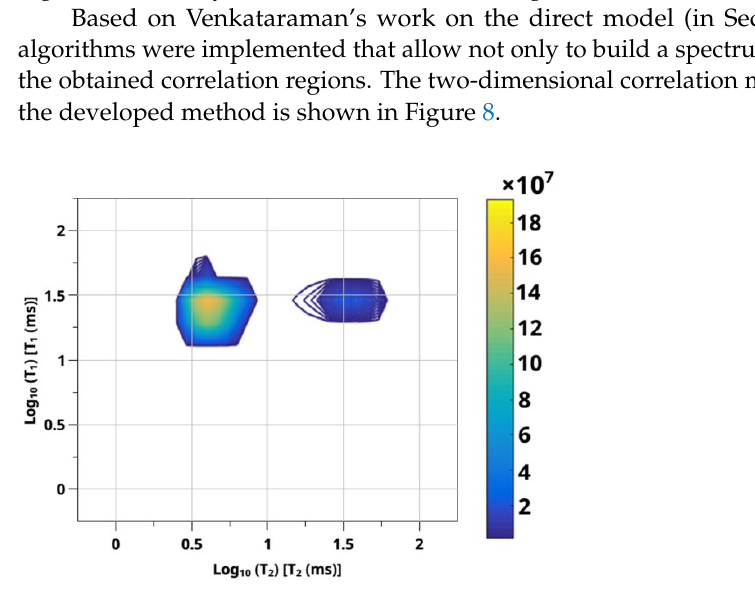
Figure 8. Two-dimensional correlation map obtained on the basis of the developed method. The ordinate and abscissa show the values of the logarithms of the relaxation times T 1 and T 2 spin–lattice to spin–spin relaxation times, respectively, while the sites in the spectroscopic image correspond to free solvent scCO 2 ( left ) and impregnated into the polymer matrix ( right ).